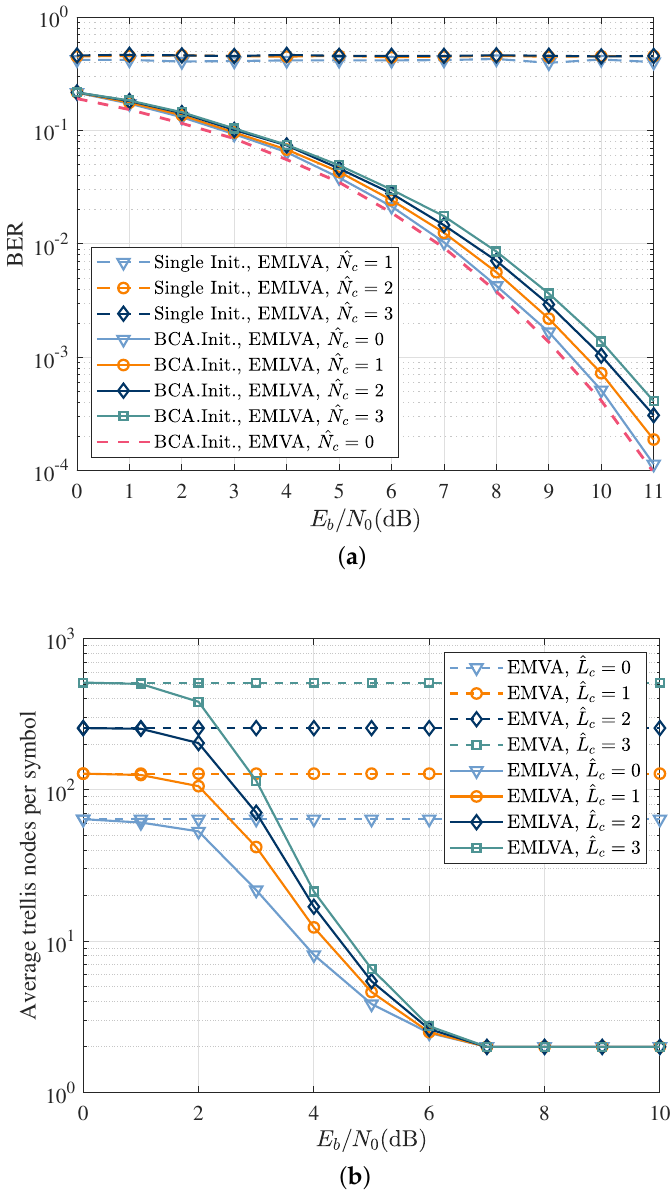
Figure 9. The performance of the EMLVA when the channel length is overestimated. ( a ) BER as a function of E b / N 0 for the blind equalizer in a Ricean fading channel when the channel length at the receiver is known ( ˆ N c = 0) and when it is overestimated ( ˆ N c = 1,2,3). BER as a function of E b / N 0 when the channel length is overestimated. ( b ) Average number of expanded trellis nodes per information symbol as a function of E b / N 0 when the channel length at the receiver is known (ˆ L c = 0) and when it is overestimated in terms of the symbol time (ˆ L c = 1,2,3). Average trellis nodes per symbol as a function of E b / N 0 when the channel length is